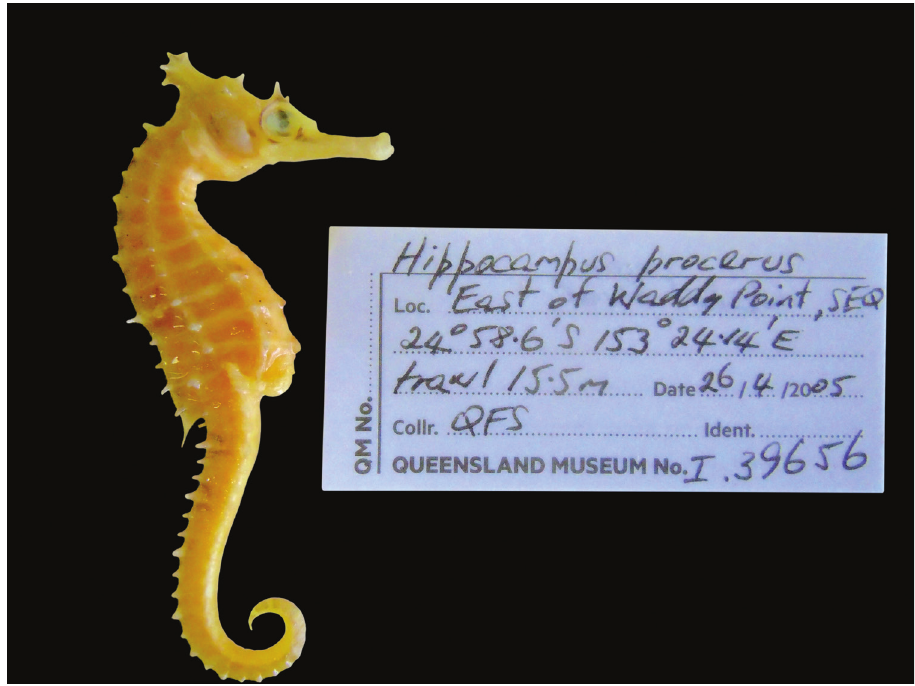
Figure 12. Hippocampus procerus , QM I.39656, adult female, non-type, Waddy Point Queensland, Aus- tralia (photograph Jeff